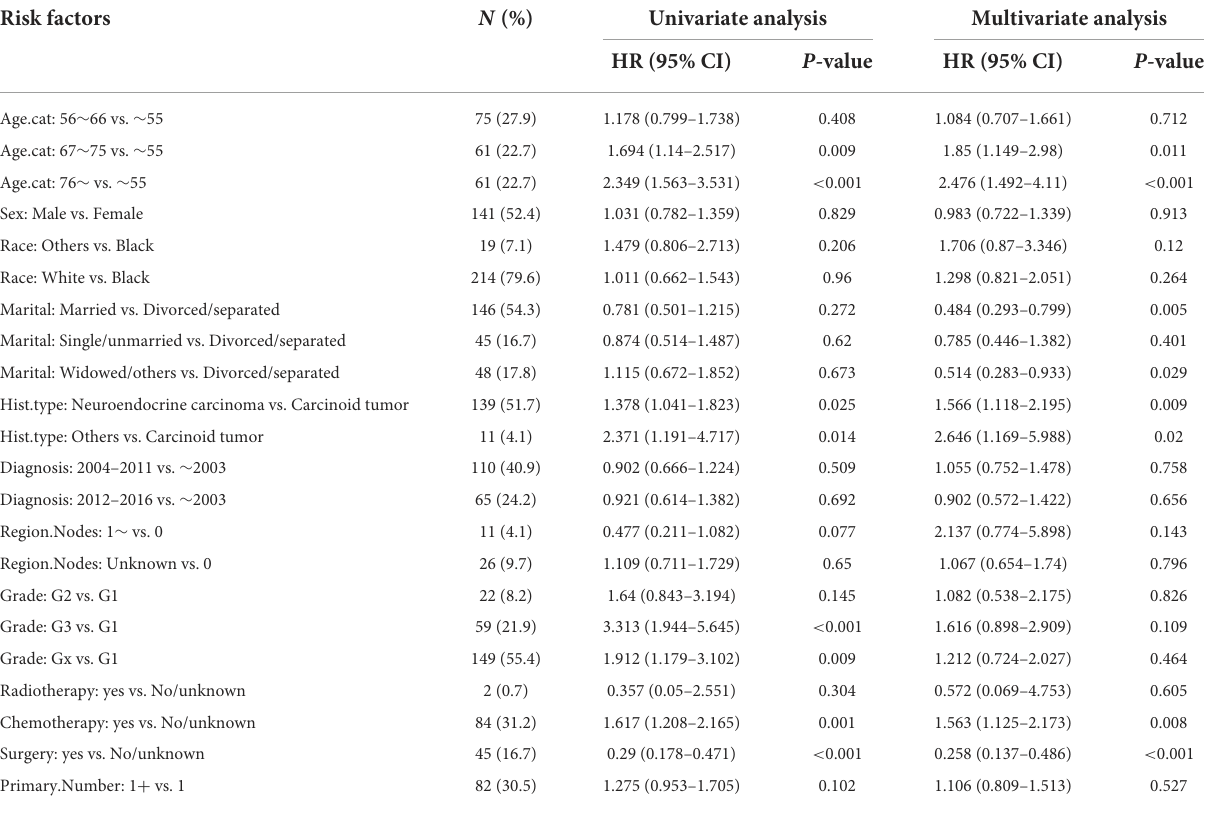
TABLE 2 Univariate and multivariate Cox analysis of factors for OS in patients with PHNET in the training set. Risk factors N (%) Univariate analysis Multivariate